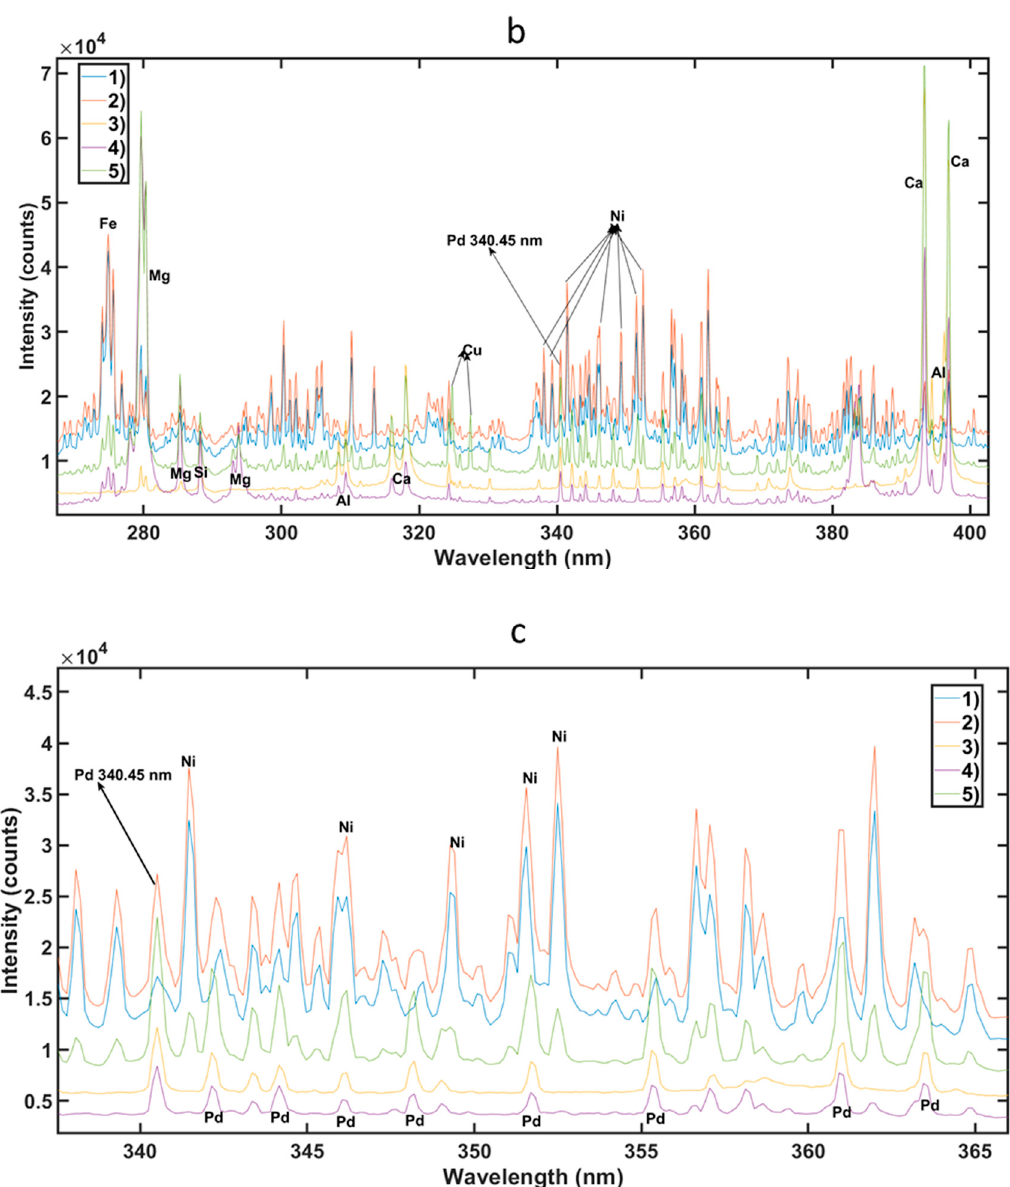
Figure 7. ( a ) Mono-elemental distribution of palladium determined by LIBS using the Pd I emission line at 340.45 nm; ( b ) Spectra corresponding to the five encircled areas in Figure 7a; ( c ) Magnification of the spectra of Figure 7b between 337.5 and 366 nm.